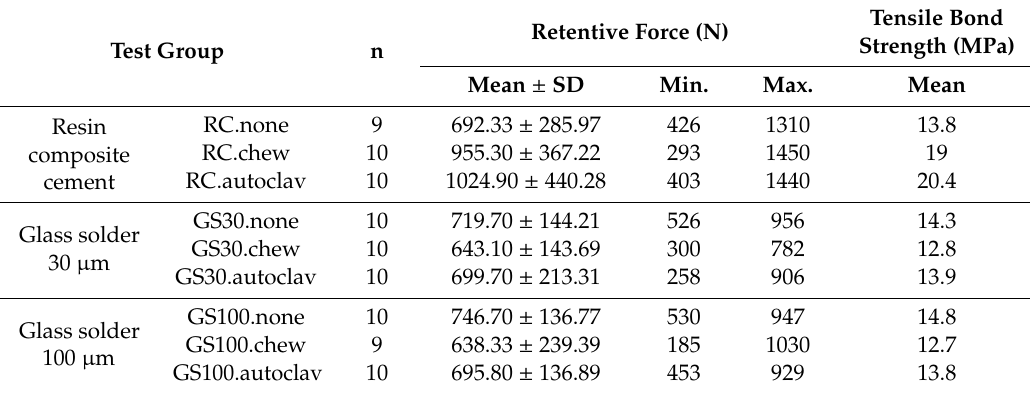
Table 2. Descriptive statistics of the retentive forces (N) and tensile bond strengths